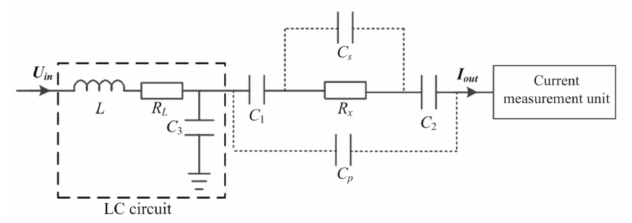
Figure 4. The equivalent circuit of the new C 4 D